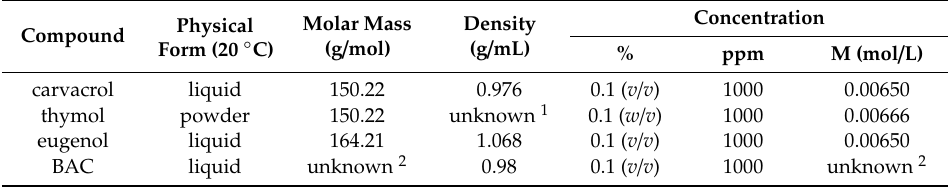
Figure 1. Chemical formulas of the four tested compounds. Table 1. Main physical and chemical properties of the four tested compounds, together with the correlations in concentrations (for each compound) expressed in either as ppm or molarity (M), using the 0.1% ( v / v or w / v ) as a reference concentration.